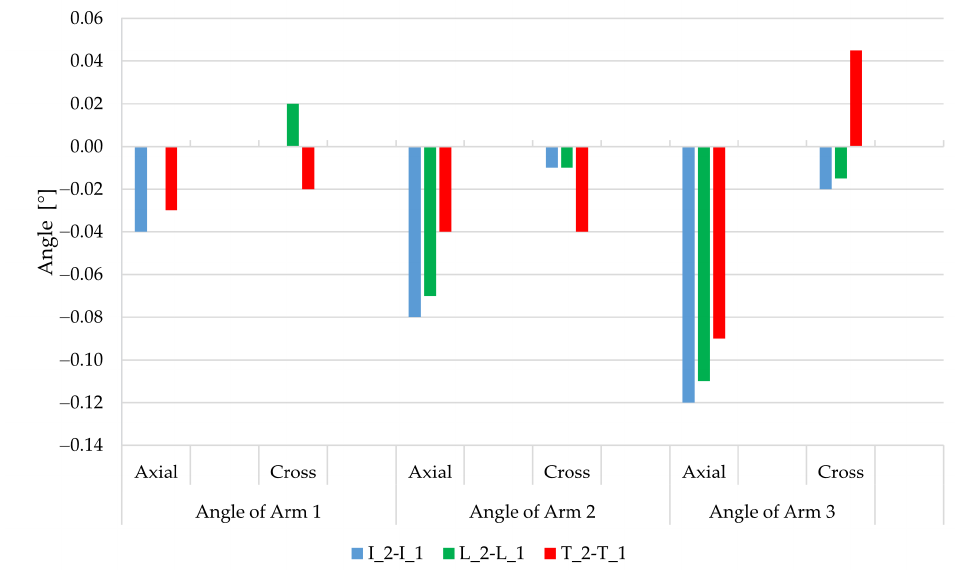
Figure 14. Change in arm angle after actuator loading